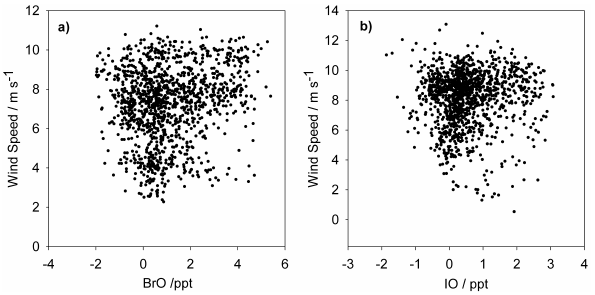
Fig. 2. Correlation of BrO and IO with wind speed at S˜ao Vicente. Panel (a) shows the correlation for BrO and (b) show a similar plot for IO. There is no significant correlation for either species: for [BrO] vs. wind speed, linear regression through the data has an R 2 = 0.02, while for [IO] vs. wind speed, R 2 =